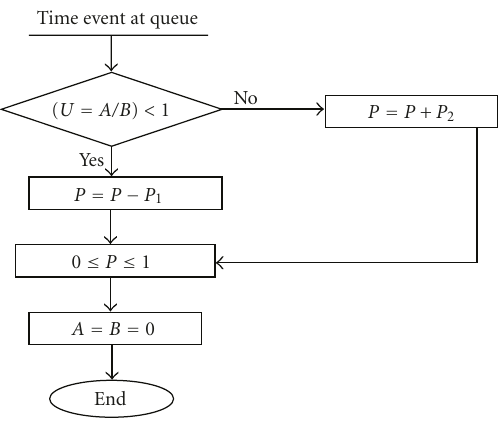
Figure 4: Timer event.